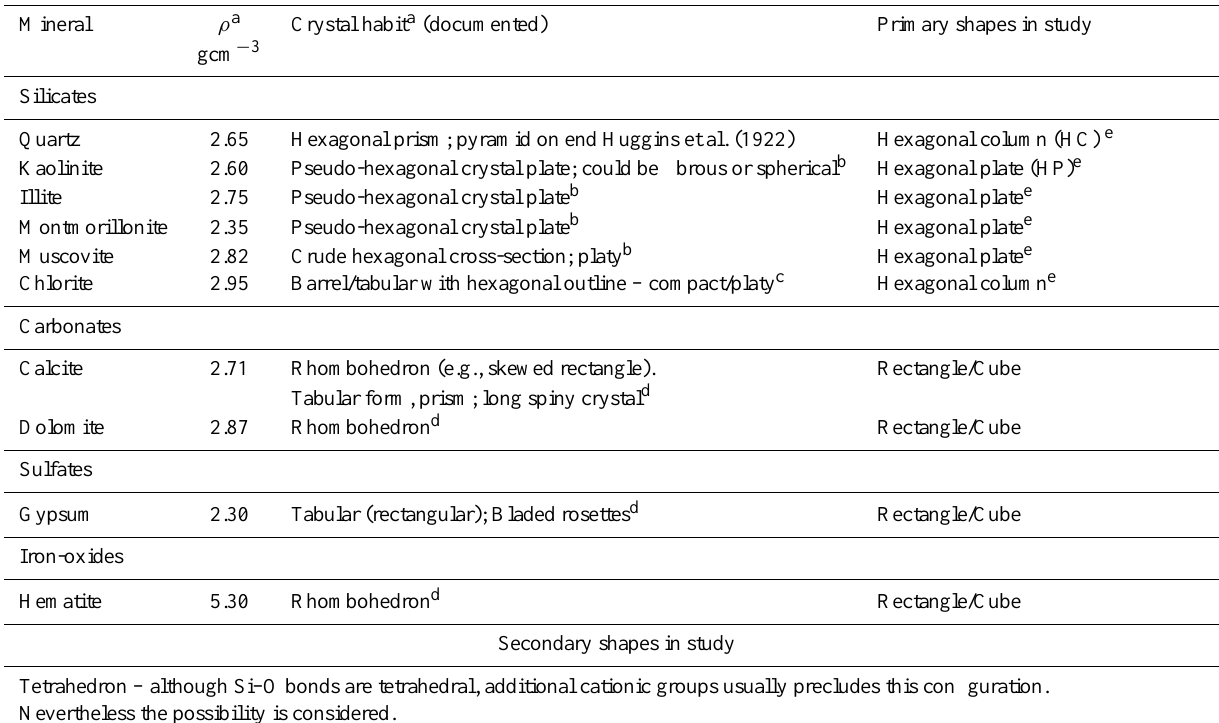
Table 3. Densities and shapes of common dust